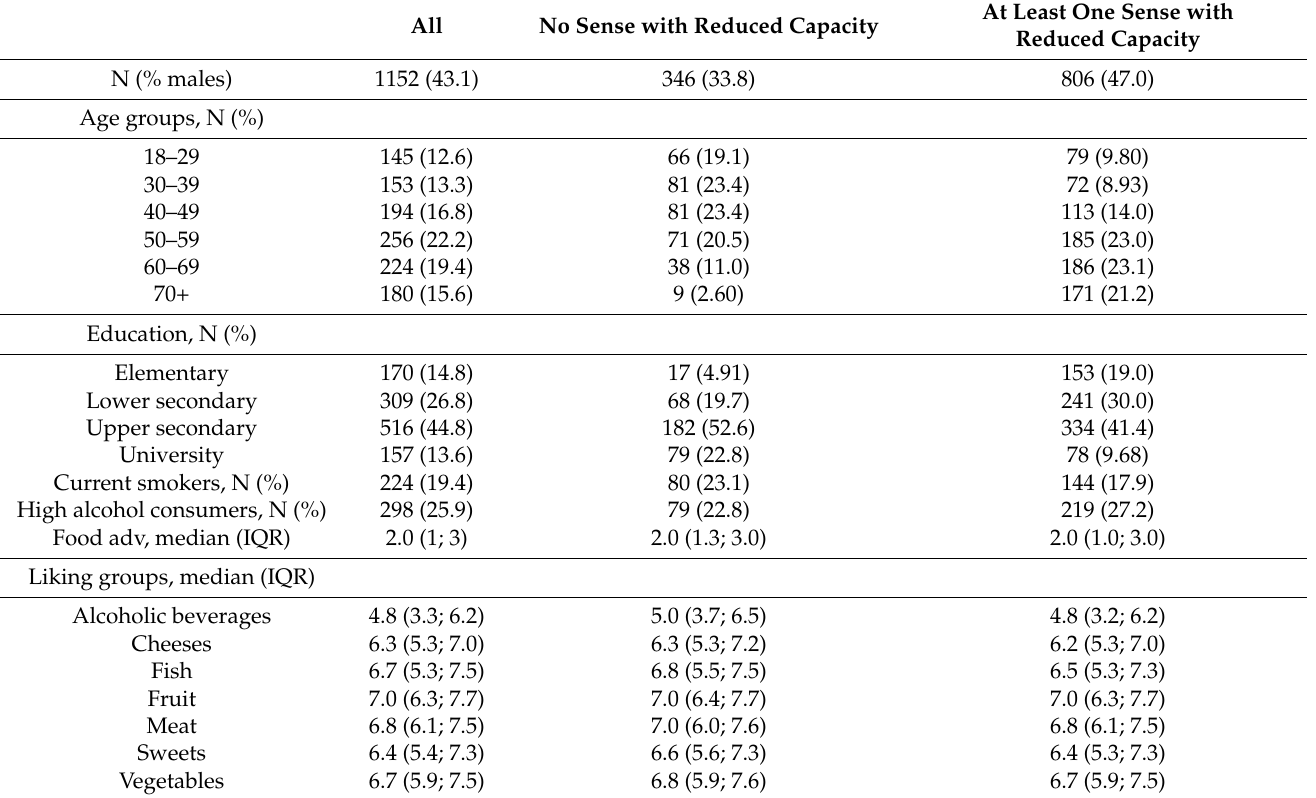
Table 1. Characteristics of study participants, considering all the individuals and according to sensory status (i.e., no sense with reduced capacity and at least one sense with reduced capacity). IQR = interquartile range; Food adv = food